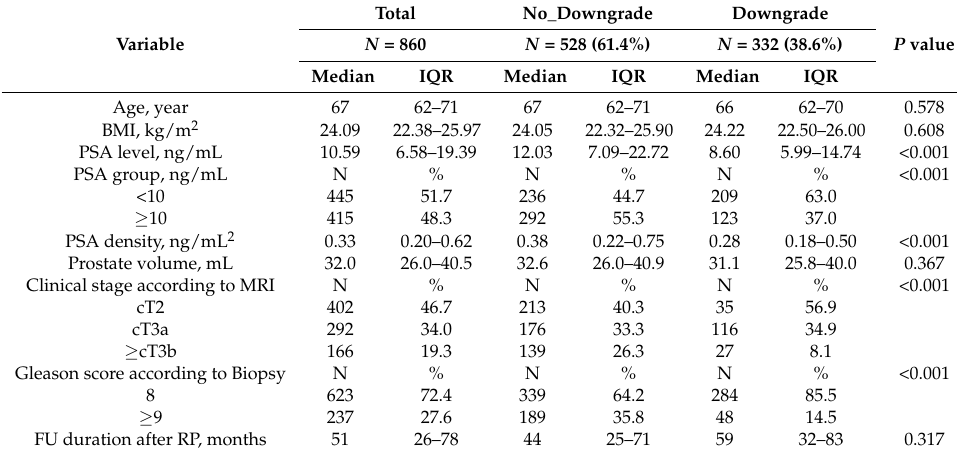
Table 1. Baseline patient